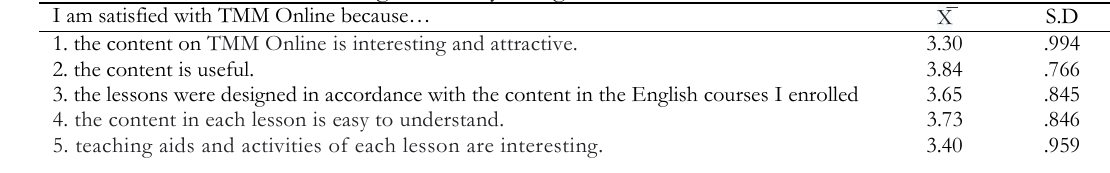
TABLE 4 . Attitude towards doing self-study using TMM Online focused on content and materials